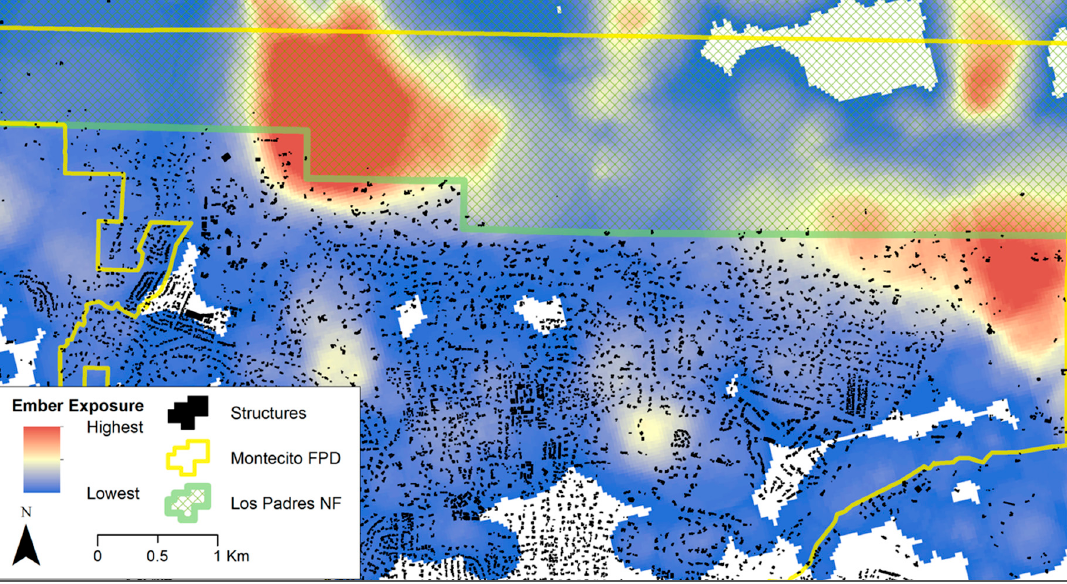
Figure 3. The Montecito Community Wildfire Protection Plan used fire modeling to geospatially characterize ember exposure and defensibility across the community with respect to structures, in order to prioritize key areas for future vulnerability reduction activities. ( Adapted from [51]).